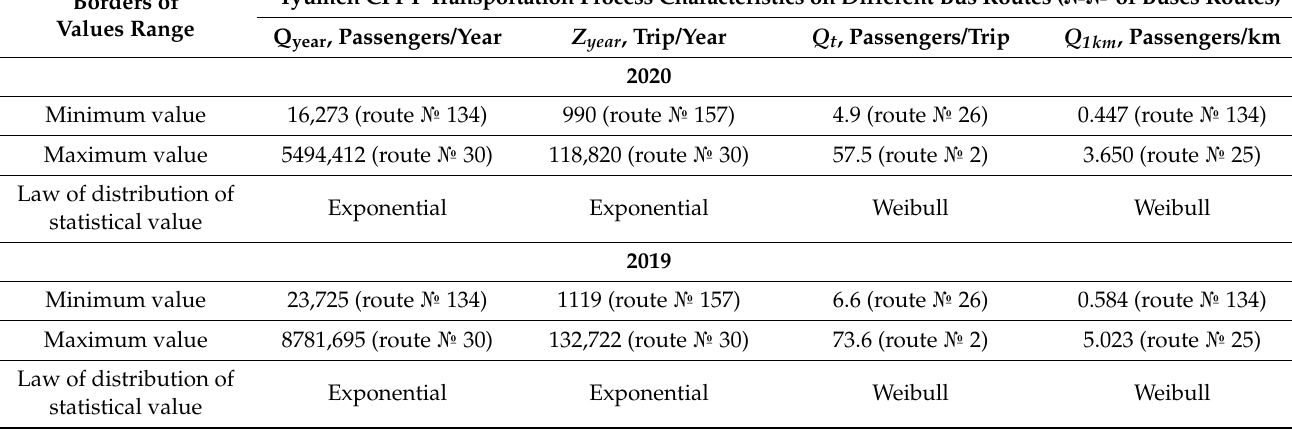
Table 6. Range of actual values of characteristics of the Tyumen CPPT transportation process on different bus routes in 2020 in comparison to analogs in